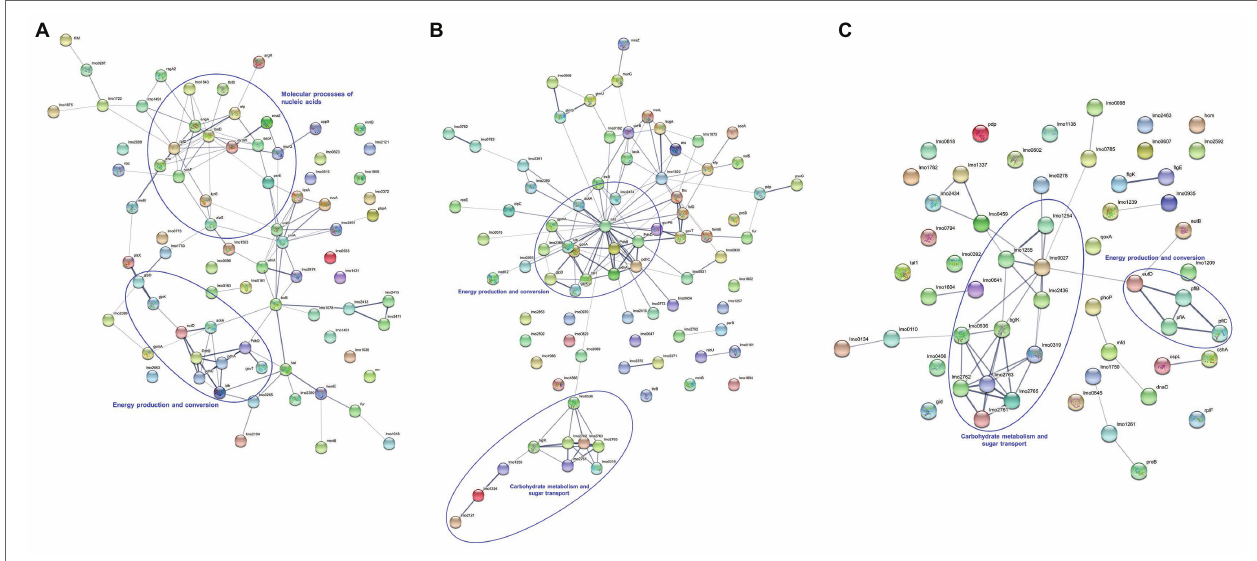
FIGURE 4 | Protein-protein interactions of differentially expressed proteins identified by comparison of untreated biofilm (A) , lactocin 705-treated biofilm (B) with planktonic cells and between sessile cells with and without treatment (C) . The thickness of lines between the nodes indicating the degree of